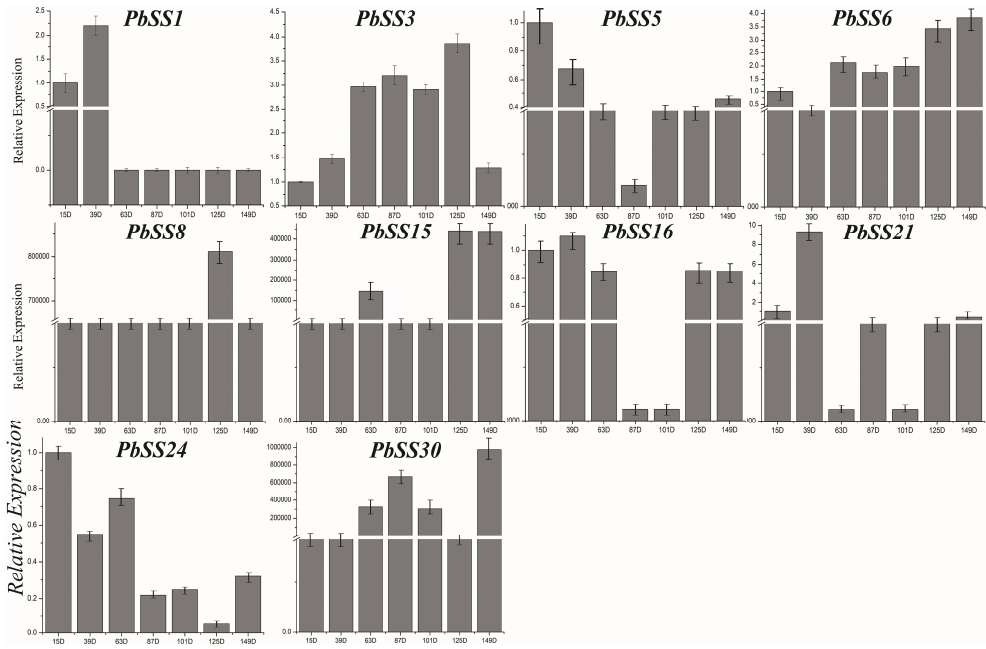
Figure 7. Expression patterns of PbSSs genes during different development stages, including 15, 39, 63, 22, 87, 101, 125 and 149 (DAF) as determined by qRT-PCR experiment. Mean values and standard deviations (SDs) indicated by error bars. ** significant difference ( p < 0.01), * significant difference at p < 0.05.